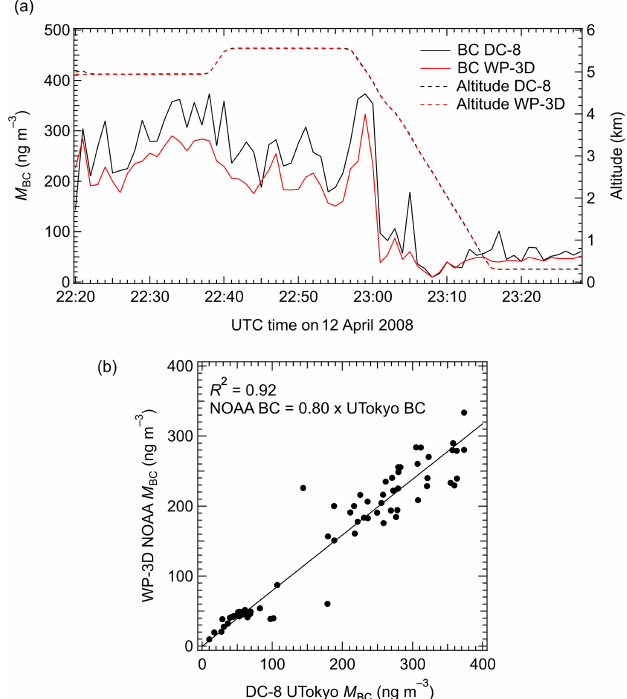
Figure A1. Comparison between M BC measurements made with The University of Tokyo SP2 during ARCTAS aboard the NASA DC-8 (black lines; Sahu et al., 2012) and NOAA SP2 measurements aboard the NOAA WP-3D (red lines, NOAA-ARCPAC experiment; Spackman et al., 2010). (a) Time series of 1min data of M BC val- ues (solid lines) and aircraft altitudes (dashed lines). (b) Scatterplot between these M BC values. The solid line is the least-squares fitted line forced through (0, 0).